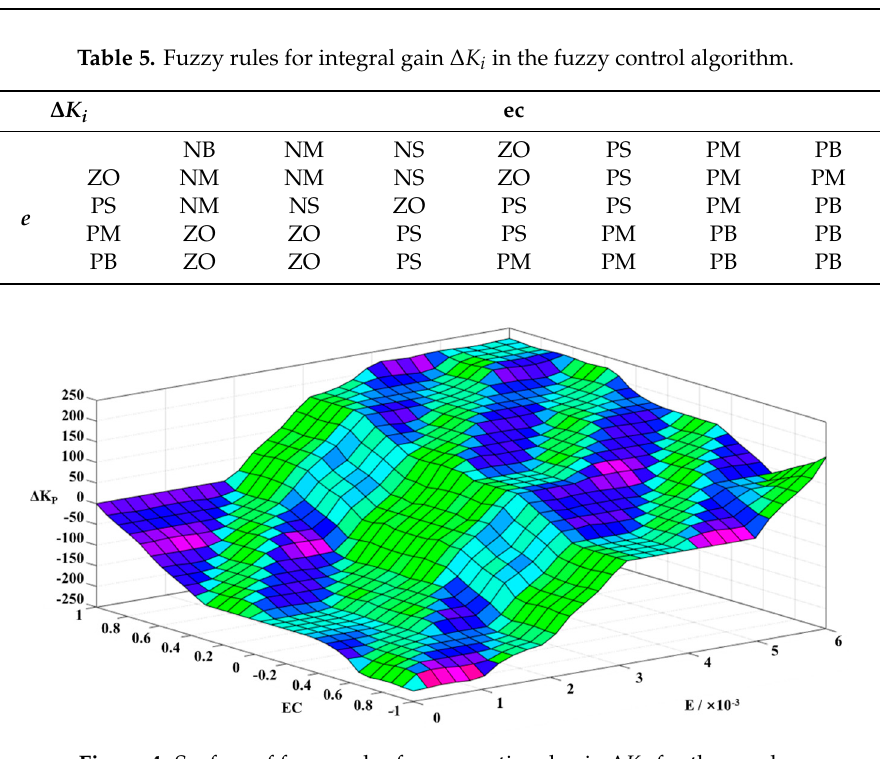
Figure 4. Surface of fuzzy rules for proportional gain ∆ K p for the anode.